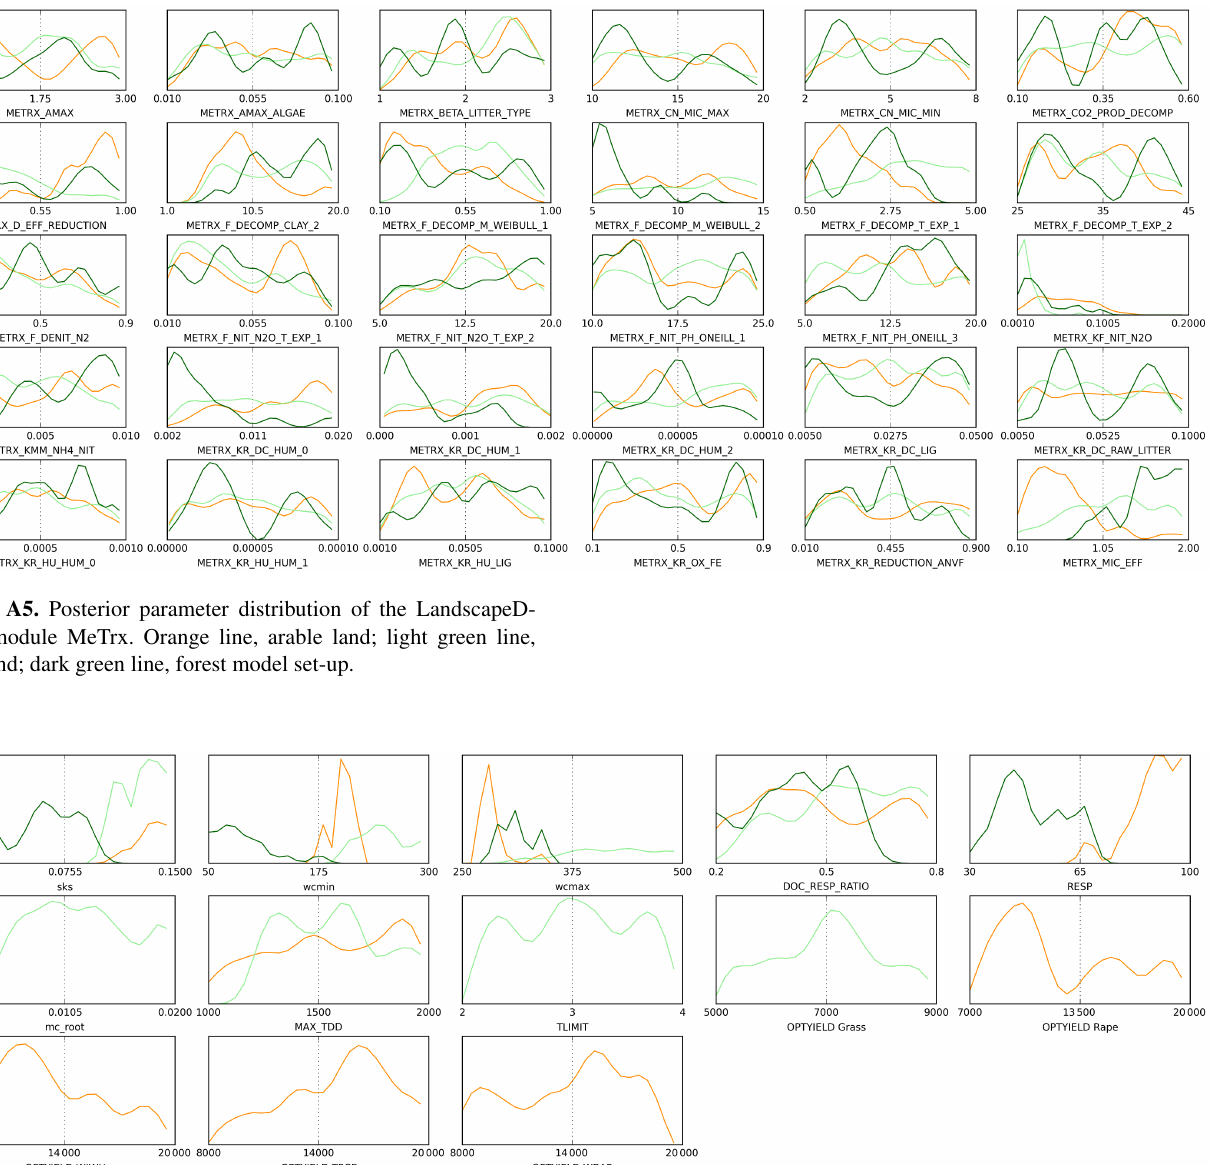
Figure A6. Posterior parameter distribution of the LandscapeD- NDC modules wcDNDC and physiology. Orange line, arable land; light green line, grassland; dark green line, forest model